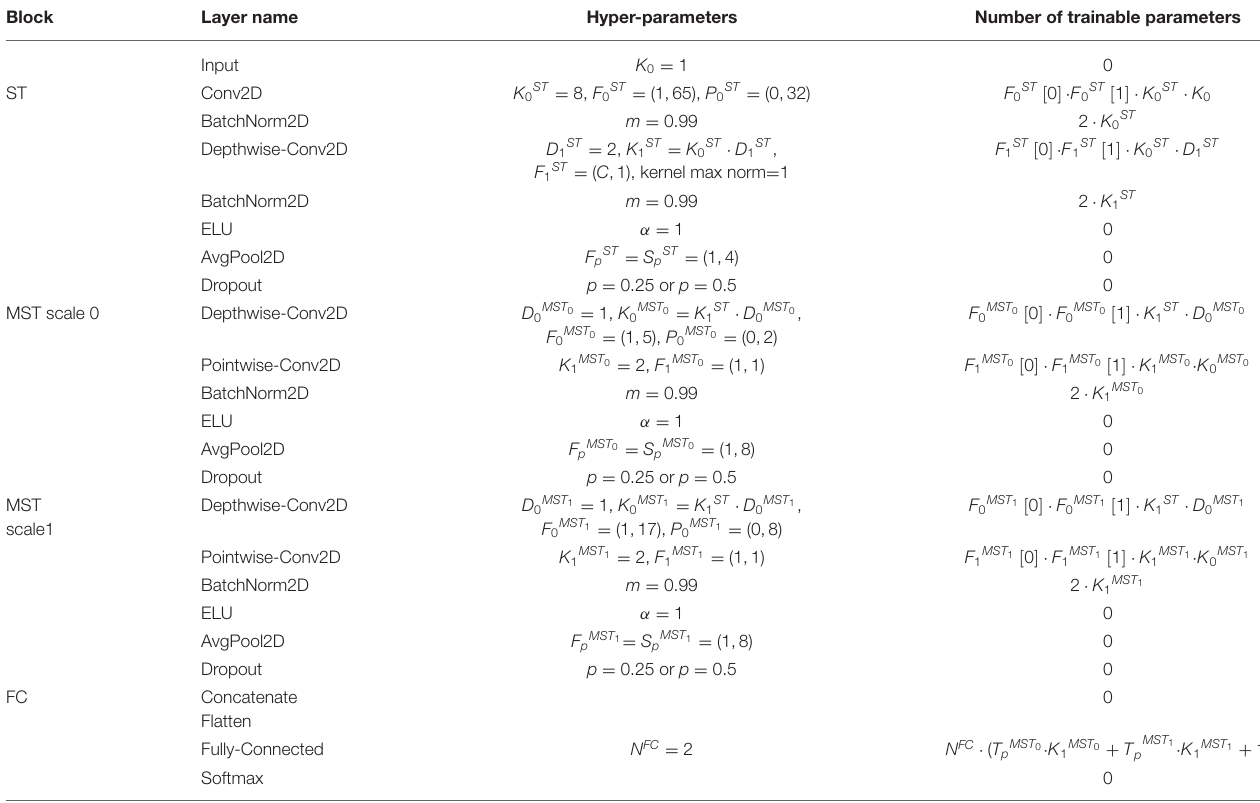
TABLE 1 | Architecture details of MS-EEGNet.